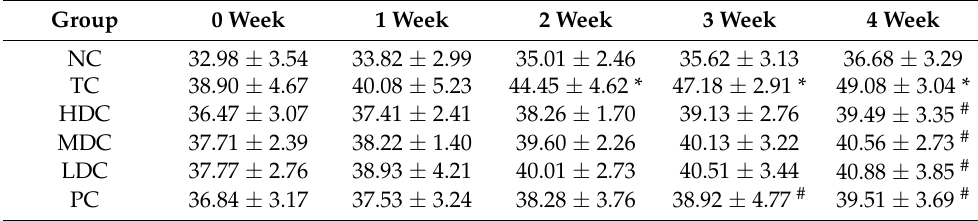
Table 3. Body weight of mice in each group (g).